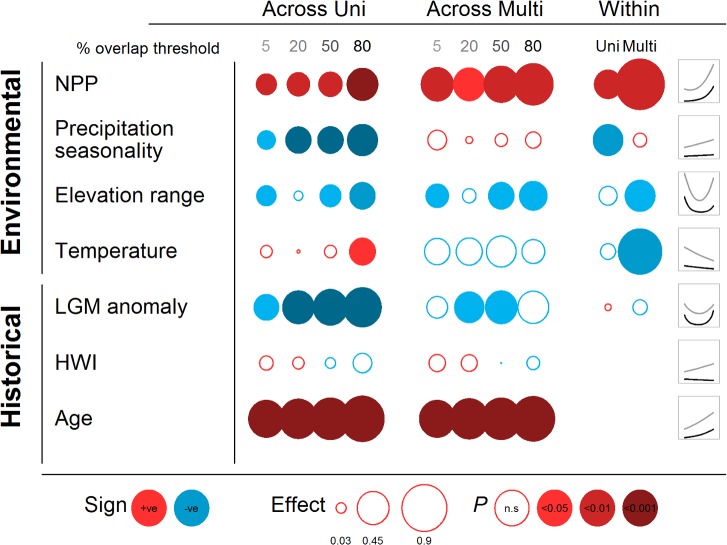
Environmental and historical predictors of species coexistence.Symbol sizes and colour denote estimated linear slopes, direction, and significance of each variable in both univariate (“Uni”) and multivariate (“Multi”) generalised linear models. Results are shown for different coexistence thresholds (5%–80% range overlap) and for models predicting coexistence across (n = 1,021 pairs) and within (n = 187 pairs) sister species pairs. Icons denote the relationship shape for each variable in the across-pair multivariate model assuming either a low (5%, light grey) or conservative (80%, dark grey) overlap threshold. For quadratic parameter estimates, see S1 Table. HWI is the “hand-wing index,” a measure of wing shape and a proxy for dispersal ability in birds (Materials and Methods). See Dryad depository for plotted data [52].